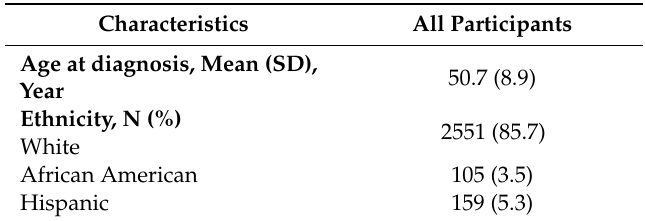
Table 1. Baseline characteristics of breast cancer survivors in the Women’s Health Eating and Living (WHEL) cohort ( n =